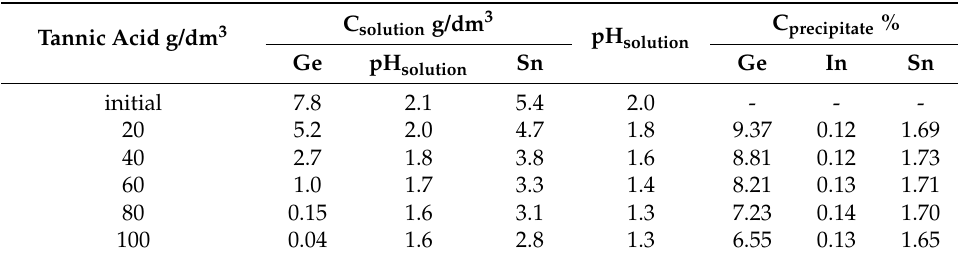
Table 2. Composition of the solution and precipitate after precipitation with tannic acid (90 ◦ C, pure tannic acid added in portions, 1 h between